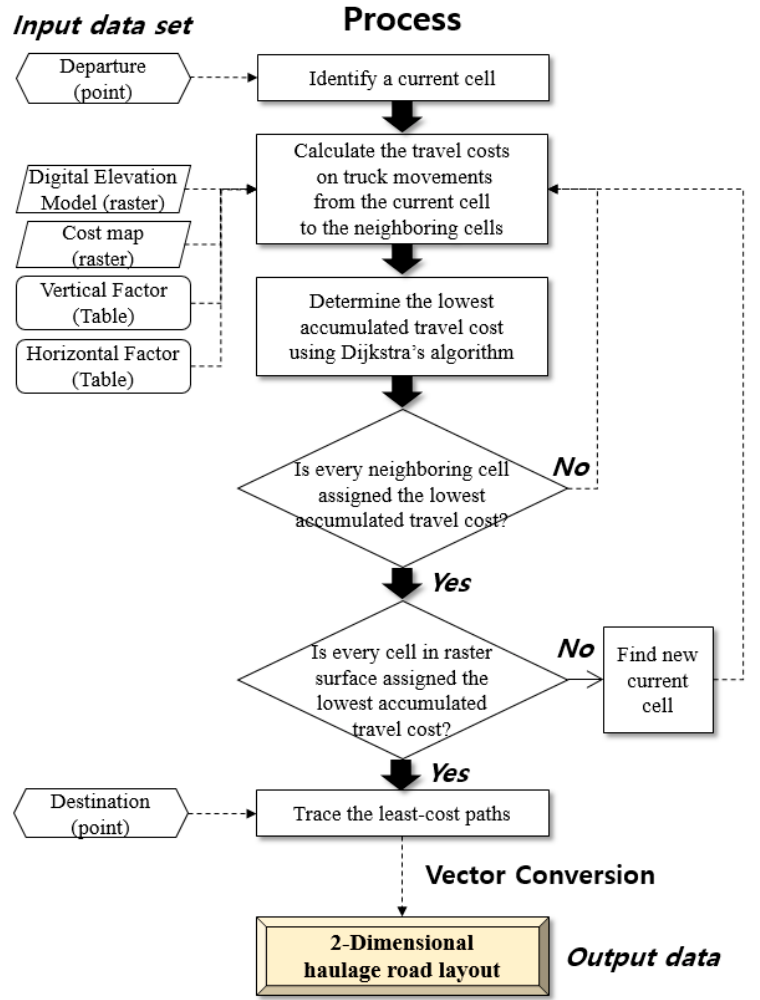
Fig 7. Figure 6. Procedure for generating 2D haulage road layout using the least-cost path analysis (LCPA)